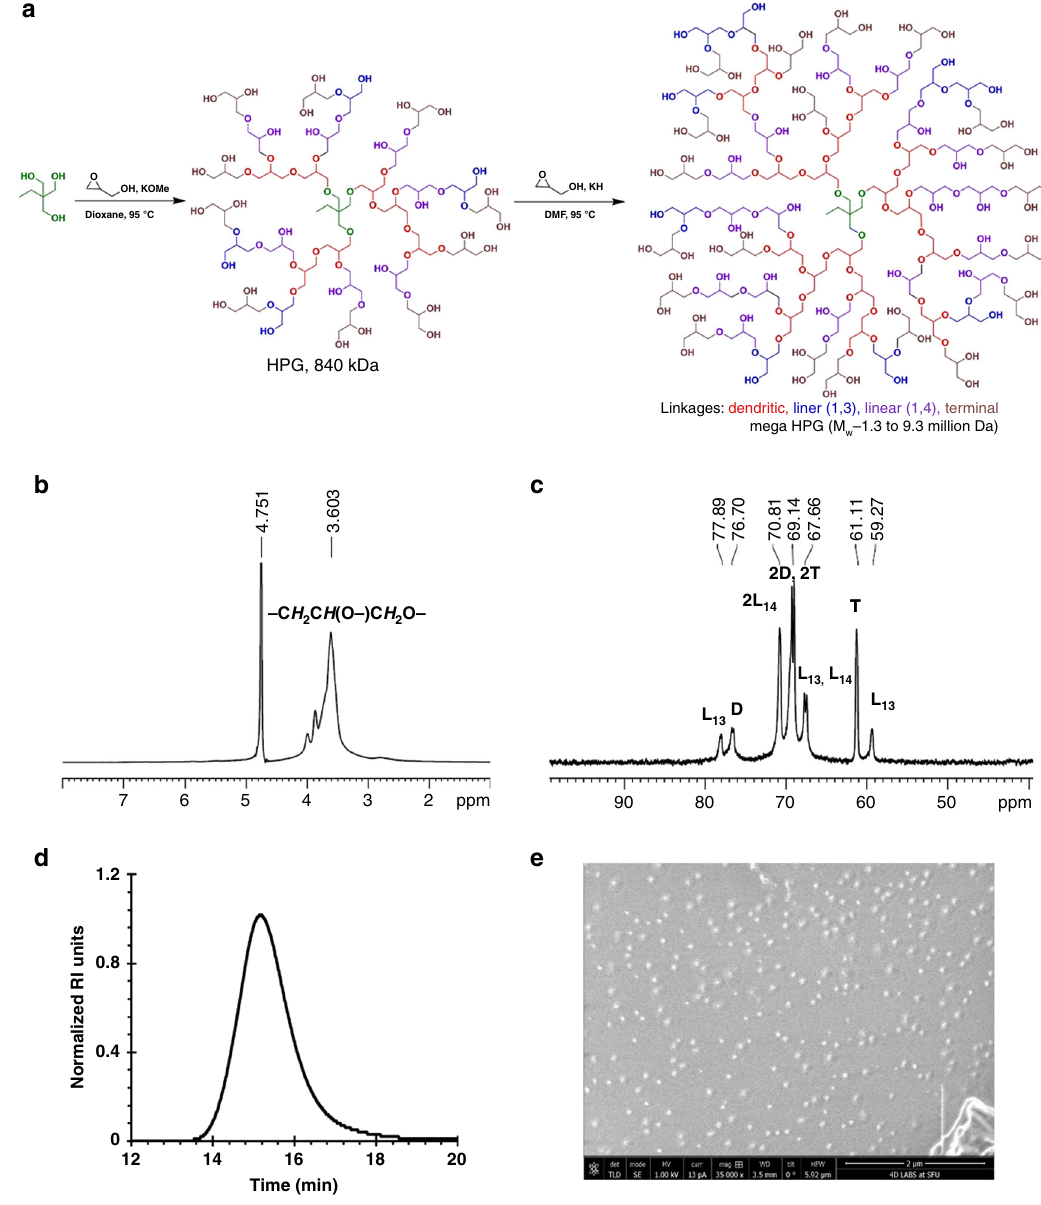
Fig. 1 Synthesis and characterization of mega HPGs. a Schematic representation of synthesis of mega HPGs ( M w : 1.3 – 9.3 MDa) by a macroinitiator approach in combination with solvent-based ring-opening multibranching polymerization. b 1 H NMR and c 13 C IG NMR characterization con fi rmed the structural features of the mega HPG-3. d Gel permeation chromatography analysis shows the monomodal distribution of mega HPG-3. e Formation of single particles and globular shape of mega HPG-3 was con fi rmed by cryo-SEM.